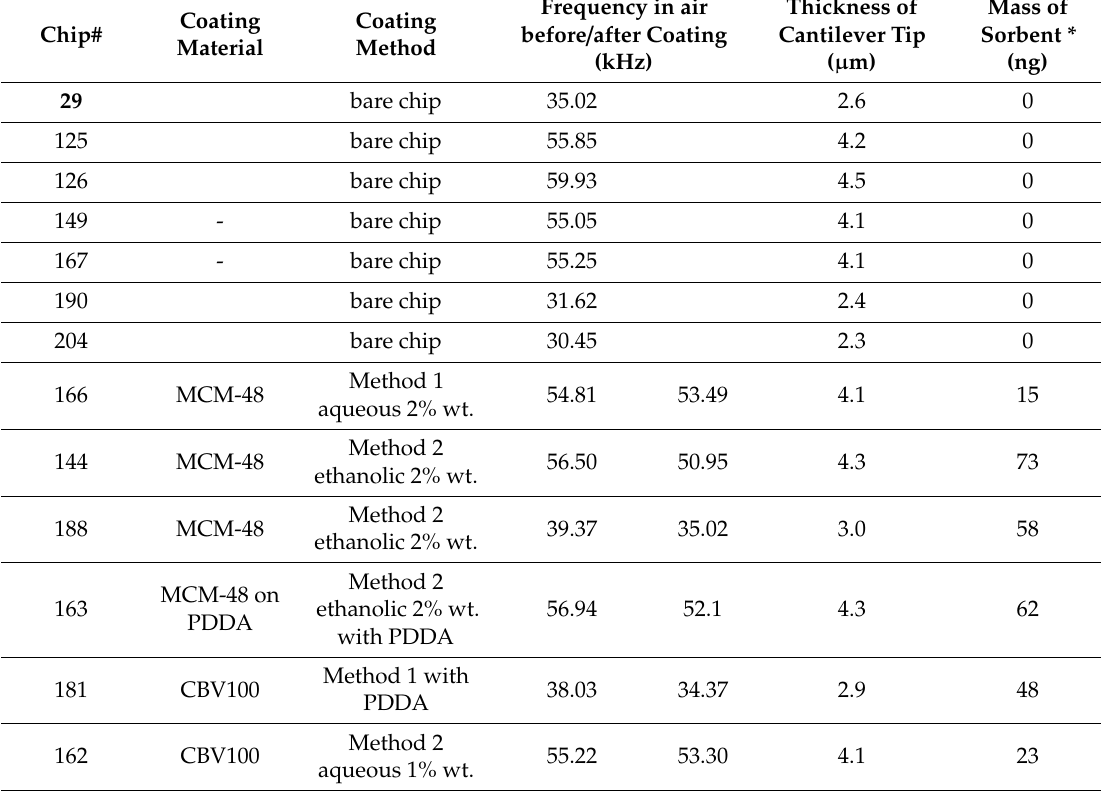
Table 2. Main characteristics of the microcantilevers measured in this